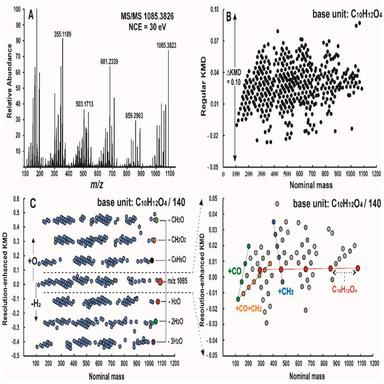
Tandem mass spectrum of the precursor ion with m/z 1085 (A) and its visualization in KMD (B) and REKMD (C, D) plots (base unit C10H12O4, X = 140).